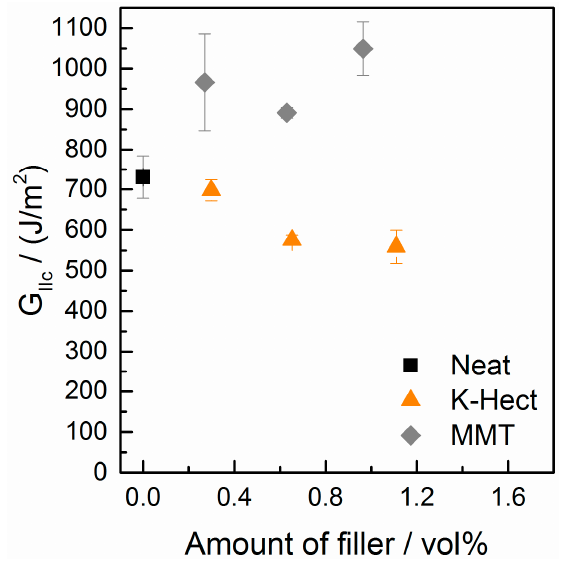
Figure 10. Energy release rate of mode II of laminates with di ff erent amounts of MMT or K-Hect.